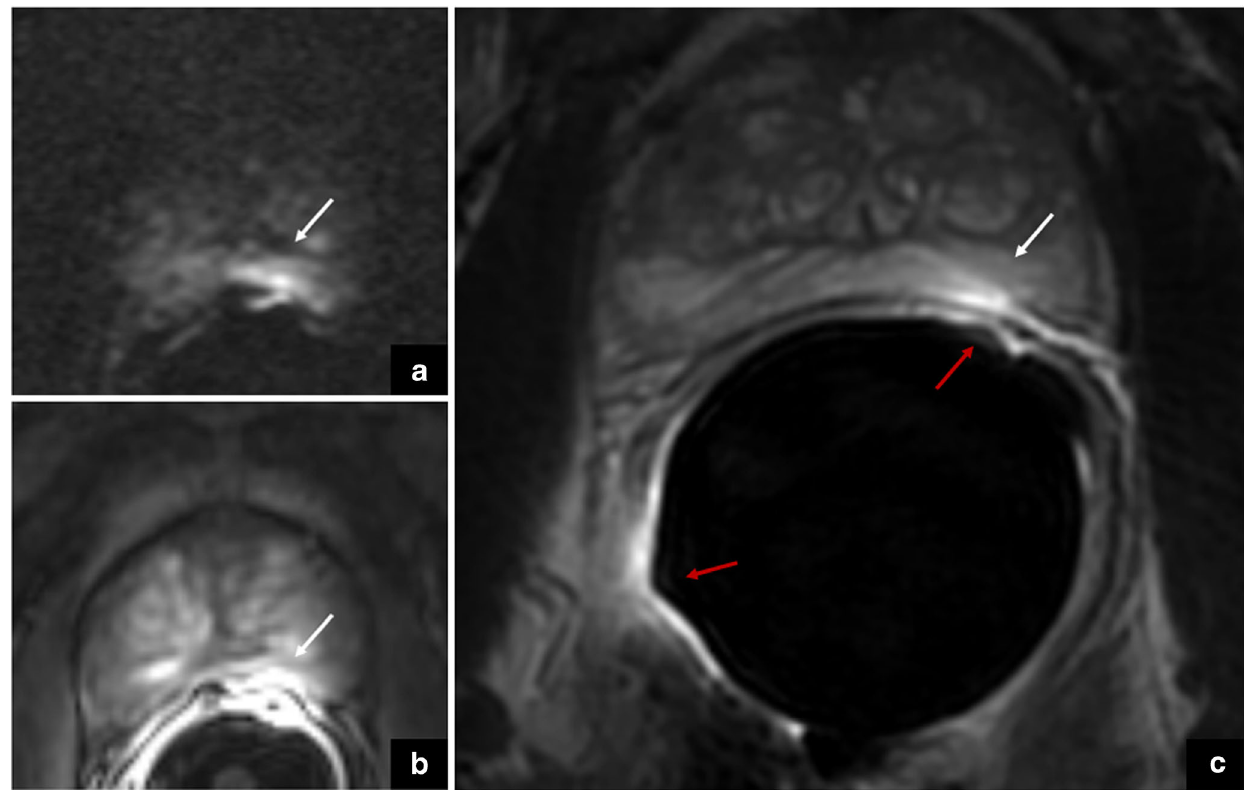
Fig.15 Thewhitearrows showanarea mimicking restricted diffusion on DWI ( a ) andfocalenhancement onDCE imaging( b ) inthe leftperipheral zone,very close totheprostatic capsule andadjacent totheendorectalcoil